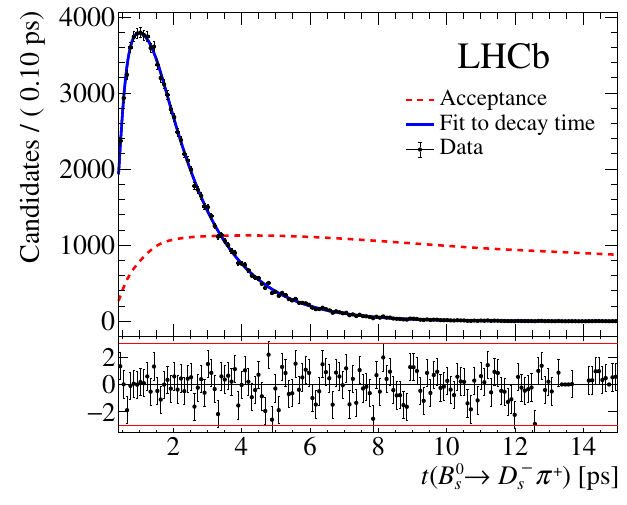
Figure 5 . Decay time distribution of B 0 D (cid:0) (cid:25) + candidates obtained by the sPlot technique. The s ! s solid blue curve is the result of the sFit procedure and the dashed red curve shows the measured decay-time acceptance in arbitrary units. Normalised residuals are shown